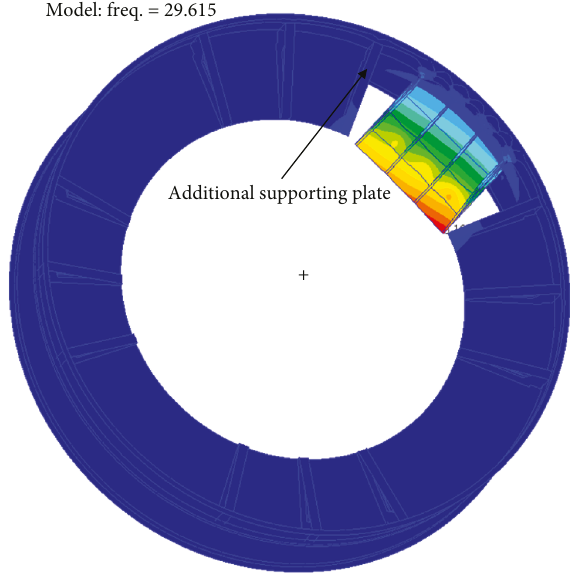
Figure 12: First modal shape of the equipment bay (with additional supporting plates).